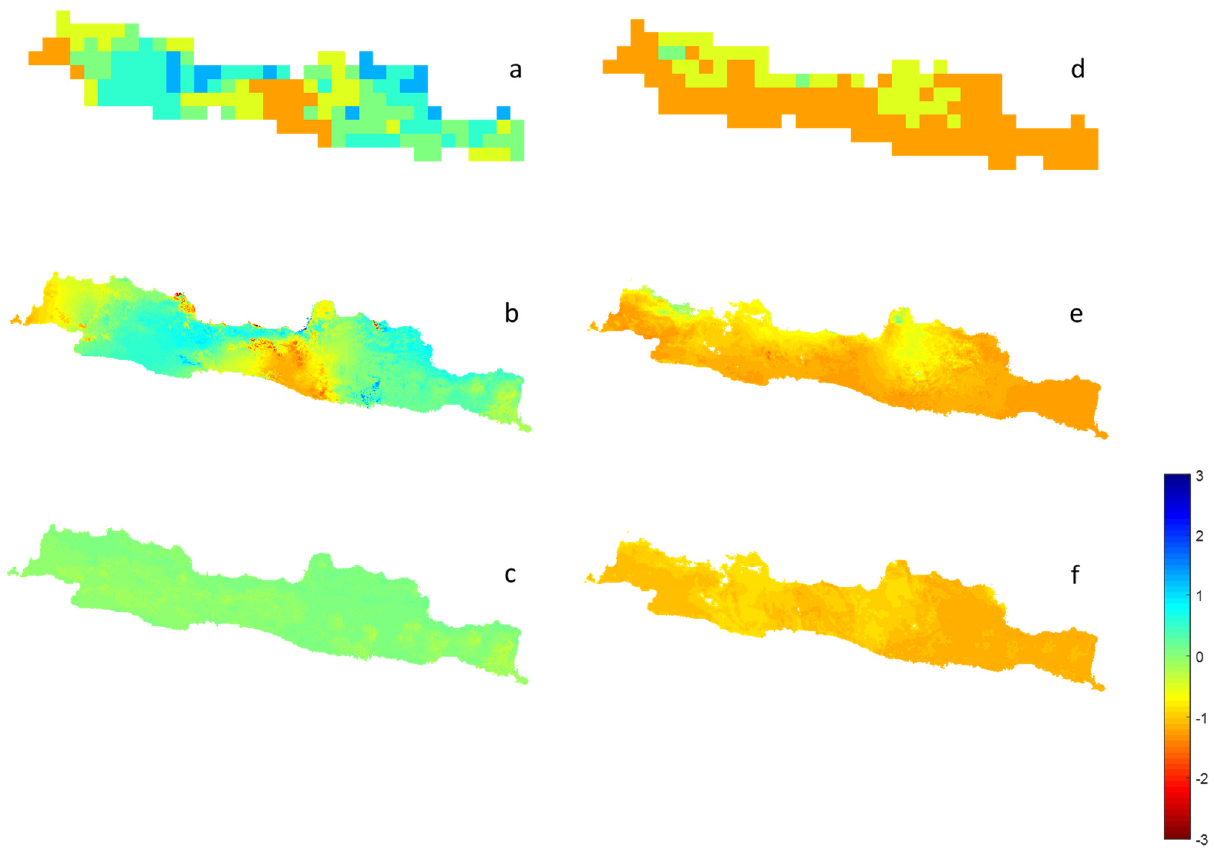
Figure 5. Spatial patterns of original SPI 6 ( a , d ), spatial downscaling ( b , e ) and nonspatial downscaling ( c , f ) results in June ( a – c ) and December ( d – f ) 2019.